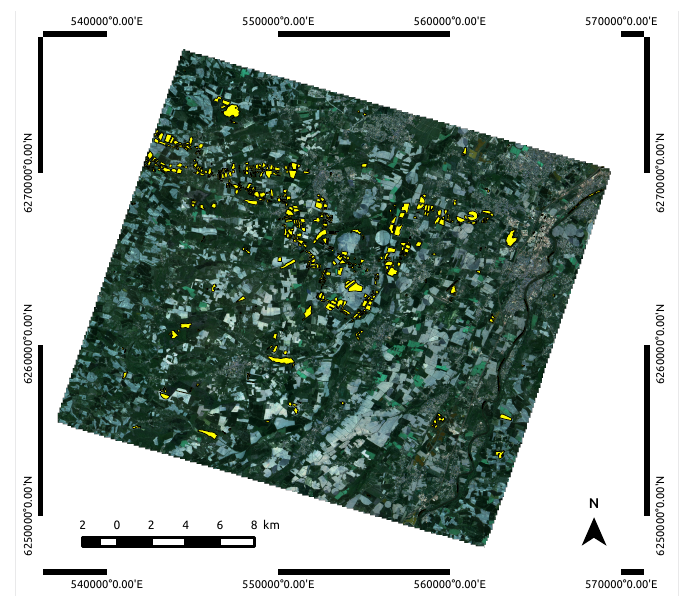
Figure 1. True-color Formosat-2 image and the corresponding reference data (yellow polygons) provided by the field campaign.